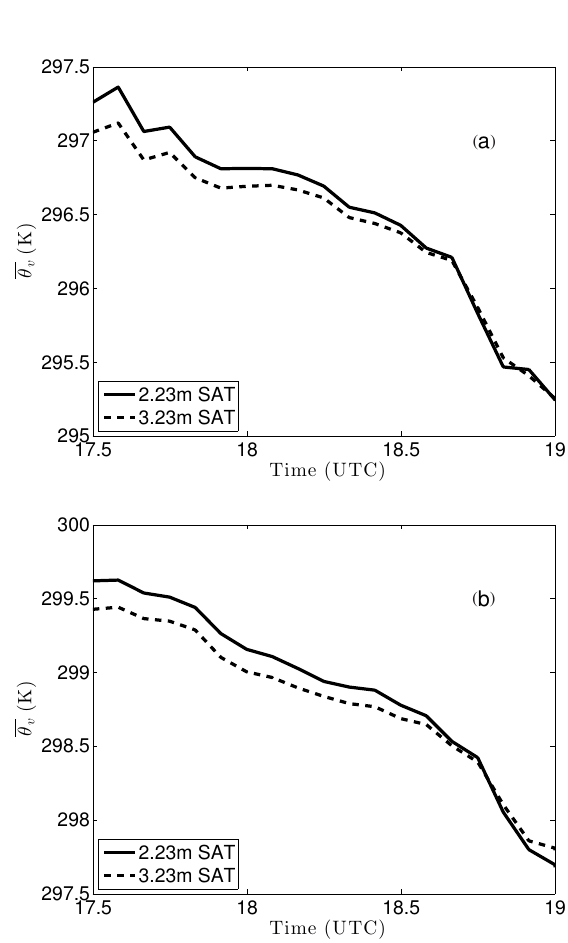
Figure 3. Observed temporal evolution of the virtual potential tem- perature at 2.23m (solid line) and 3.23m (dashed line) during the evening transitions on (a) 30 June and (b) 1 July 2011. sured at that probe. For instance, on 30 June and on 1 July 2011 the lower sensor shows that the flux ceases at approx- imately 18:18 and 17:54 UTC, respectively. The delay time between when temperature gradient and buoyancy flux pass through zero is then simply the difference between the two